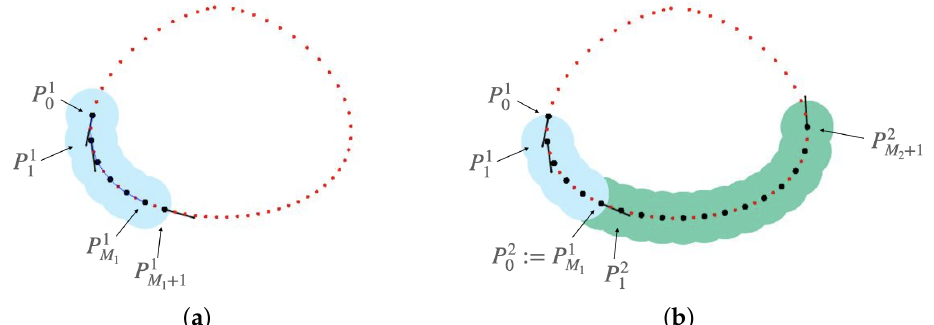
Figure 4. Graphical illustration for the computation of local tubular neighbourhoods for two iterations of the algorithm. For the sake of clarity, we here consider an over-simplified situation, with a noise- free point cloud represented in red. ( a ) First iteration; ( b ) Second